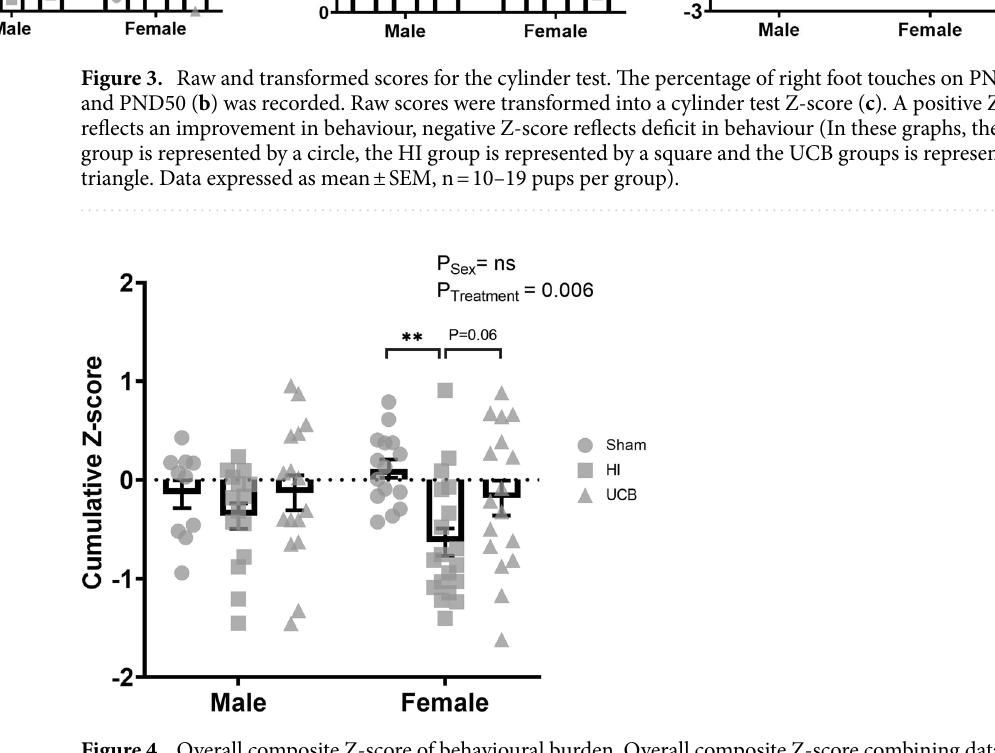
Figure 4. Overall composite Z-score of behavioural burden. Overall composite Z-score combining data from the negative geotaxis, novel object recognition and cylinder tests, from PND14, 30 and 50. A positive Z-score reflects an improvement in behaviour, negative Z-score reflects deficit in behaviour (In these graphs, the sham group is represented by a circle, the HI group is represented by a square and the UCB groups is represented by a triangle. Data expressed as mean ± SEM, n = 10–19 pups per group, **P <